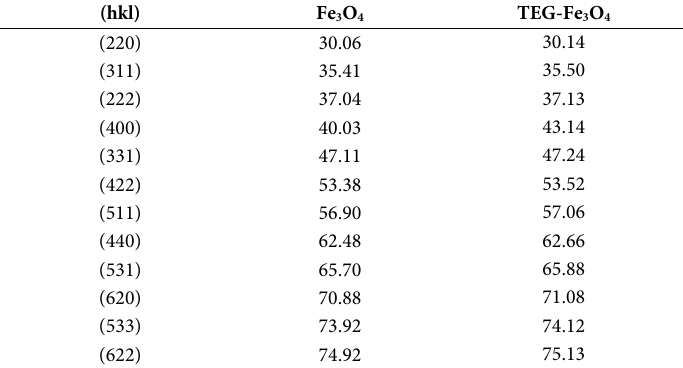
Table 1. Bragg’s reflection planes between 2 θ =20 ° -80 ° and corresponding